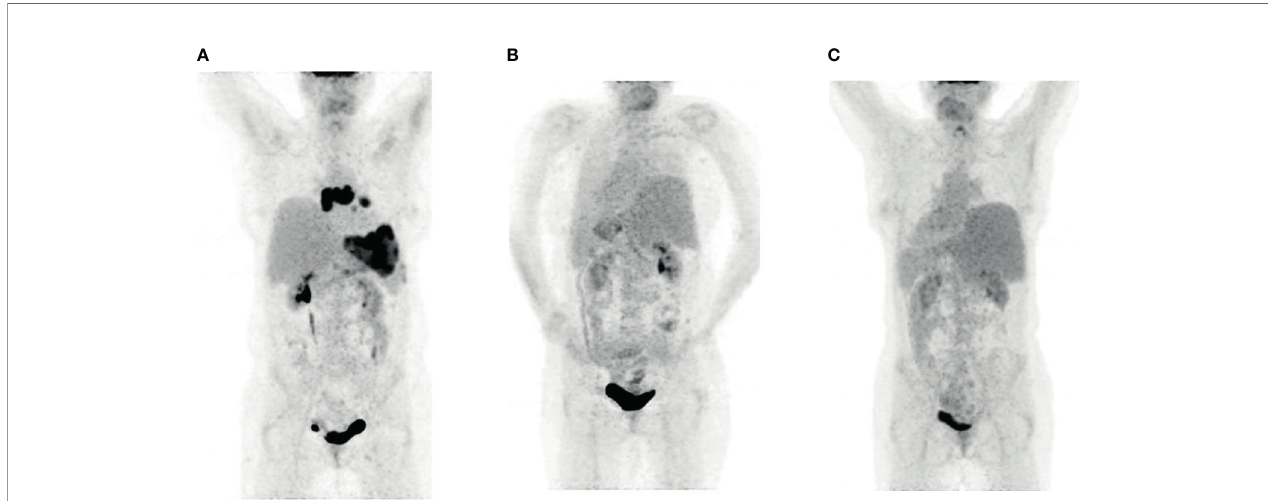
FIGURE 2 | FDG PET imaging patient 2. (A) Relapse seven months after the therapy with CAR T-cells (prior to Pola-BR). (B) Complete metabolic remission after three courses of Pola-BR. (C) Con fi rmed complete metabolic remission 52 days after